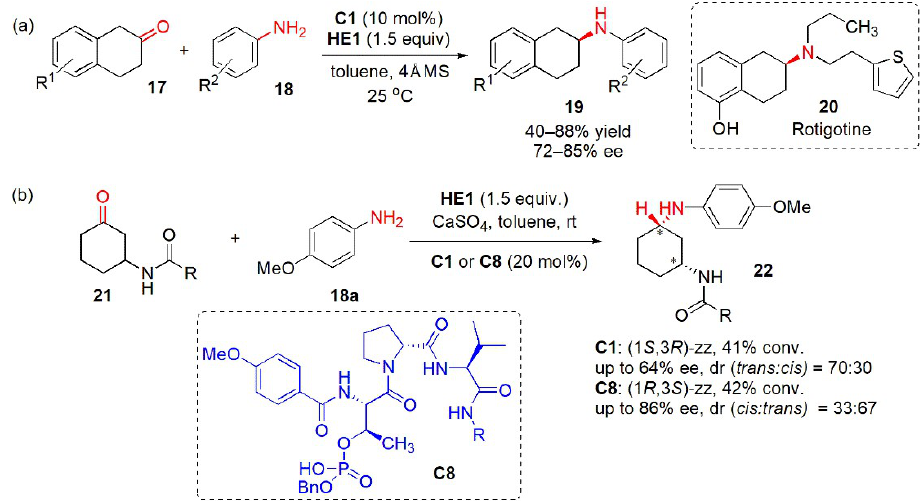
Figure 11. ( a ) Enantioselective synthesis of β-aminotetralins [57]; ( b ) Phosphothreonine-catalyzed reductive aminations of 3-amidocyclohexanones [59].